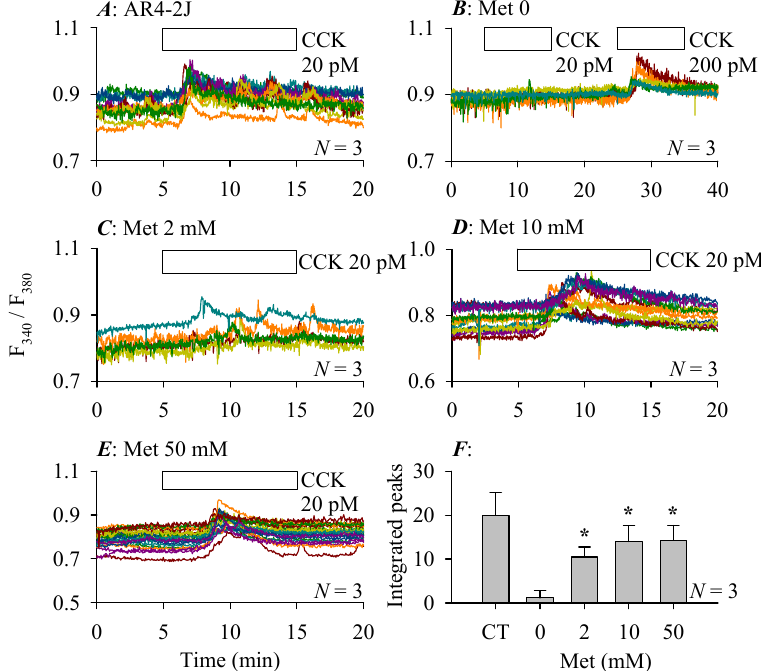
Figure 7. Co-culture inhibition of CCK-induced calcium oscillations in AR4-2J cells: reversal by Met supplementation in the co-culture medium. AR4-2J cells cultured alone ( A ) or AR4-2J co-cultured